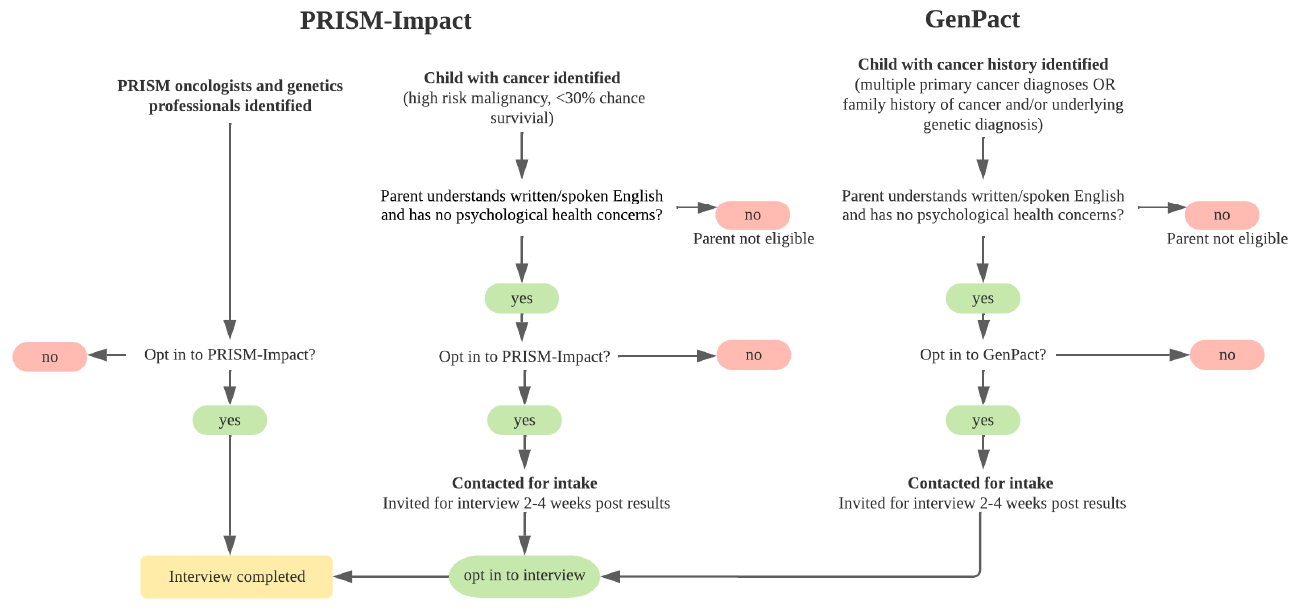
Figure 1. Recruitment